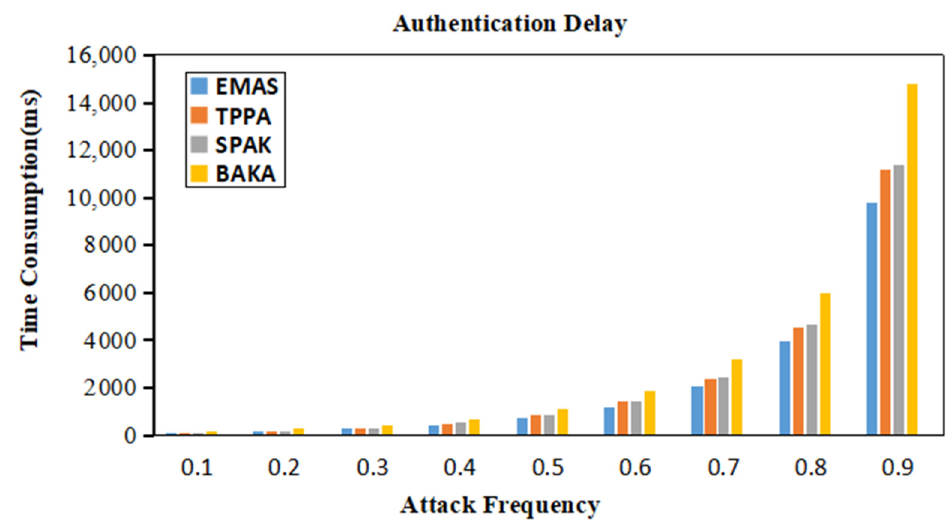
Figure 6. Computation delay of each scheme in authentication phase.